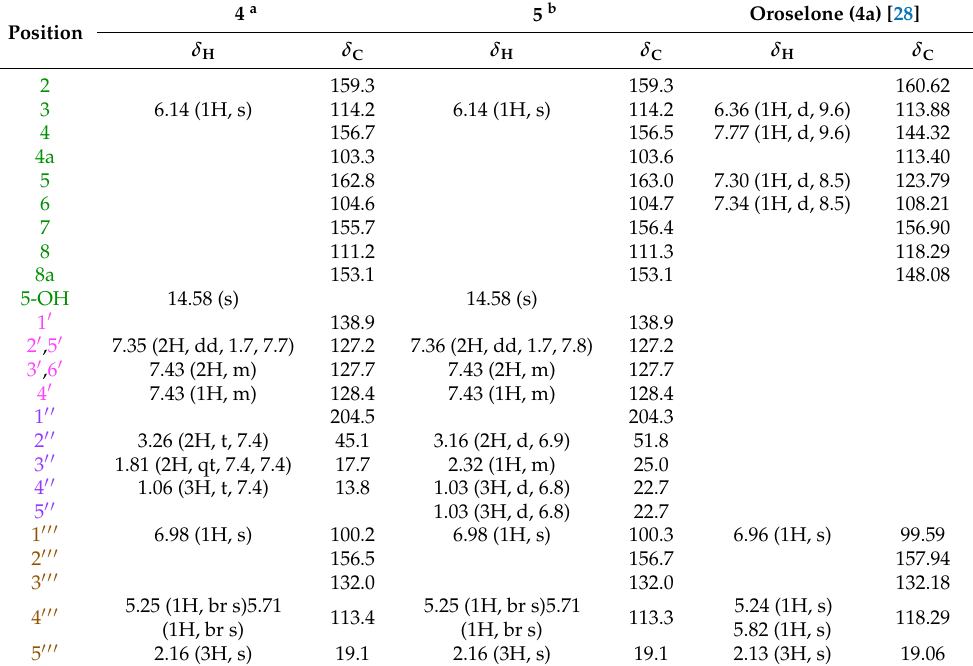
Table 4. 1 H and 13 C NMR spectroscopic data (CDCl 3 ) of mammeasins M ( 3 ) and N ( 4 ) and oroselone ( 4a ).